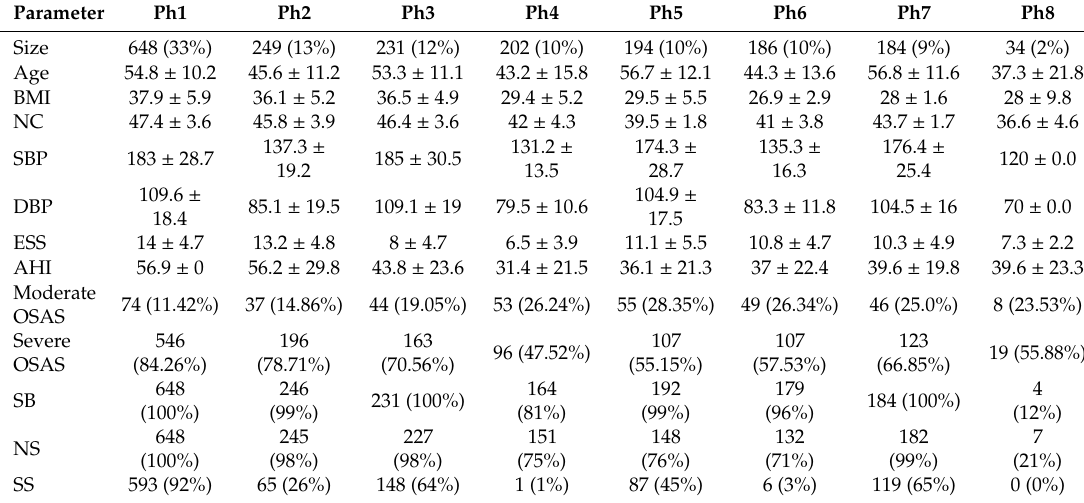
Table 2. Parameter distribution for phenotypes Ph1–Ph8 identified in the male cohort ( N = 1948). Parameter Ph1